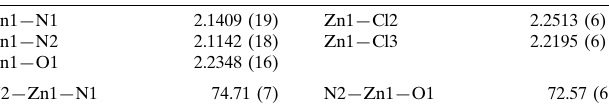
Selected geometric parameters (A˚ , (cid:2) ).